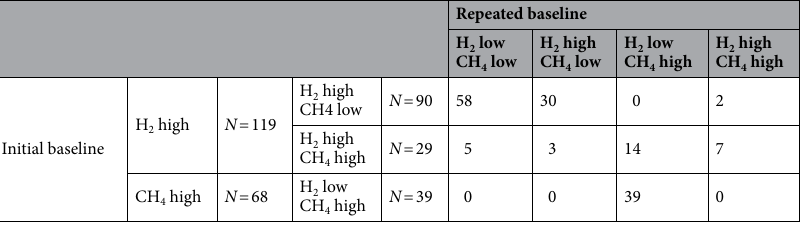
Table 2. Baseline sample classification depending on initial and repeated baseline levels compared to the corresponding cut-offs